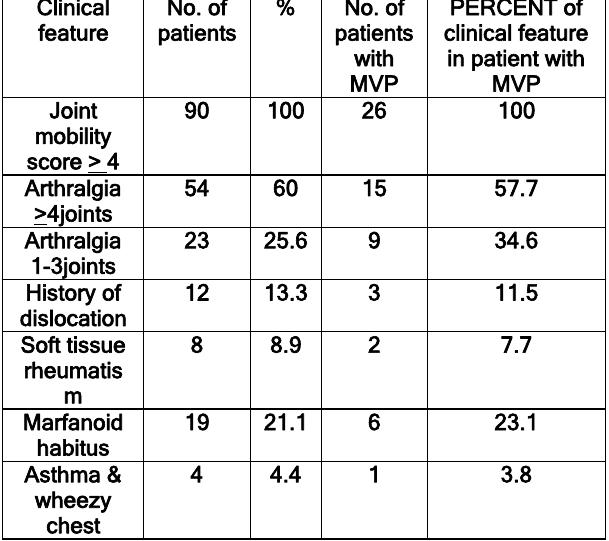
PERCENT of clinical feature in patient